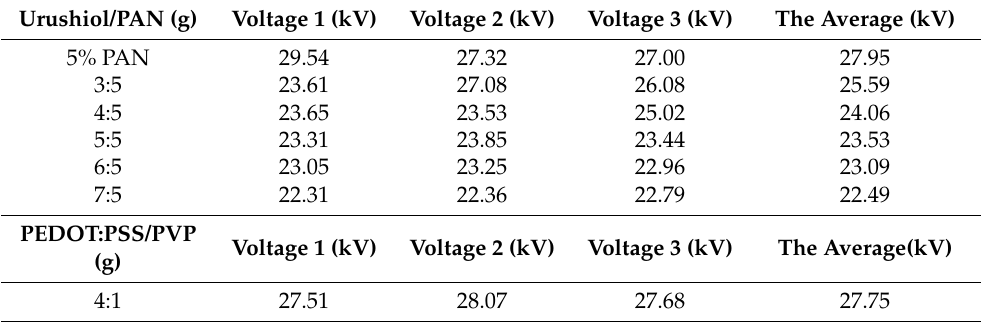
Table 1. Voltage values of urushiol/polyacrylonitrile (PAN) and Poly(3,4-ethylenedioxythiophene): poly(styrenesulfonate)(PEDOT:PSS)/polyvinyl pyrrolidone (PVP) films prepared with different urushiol/PAN mixing